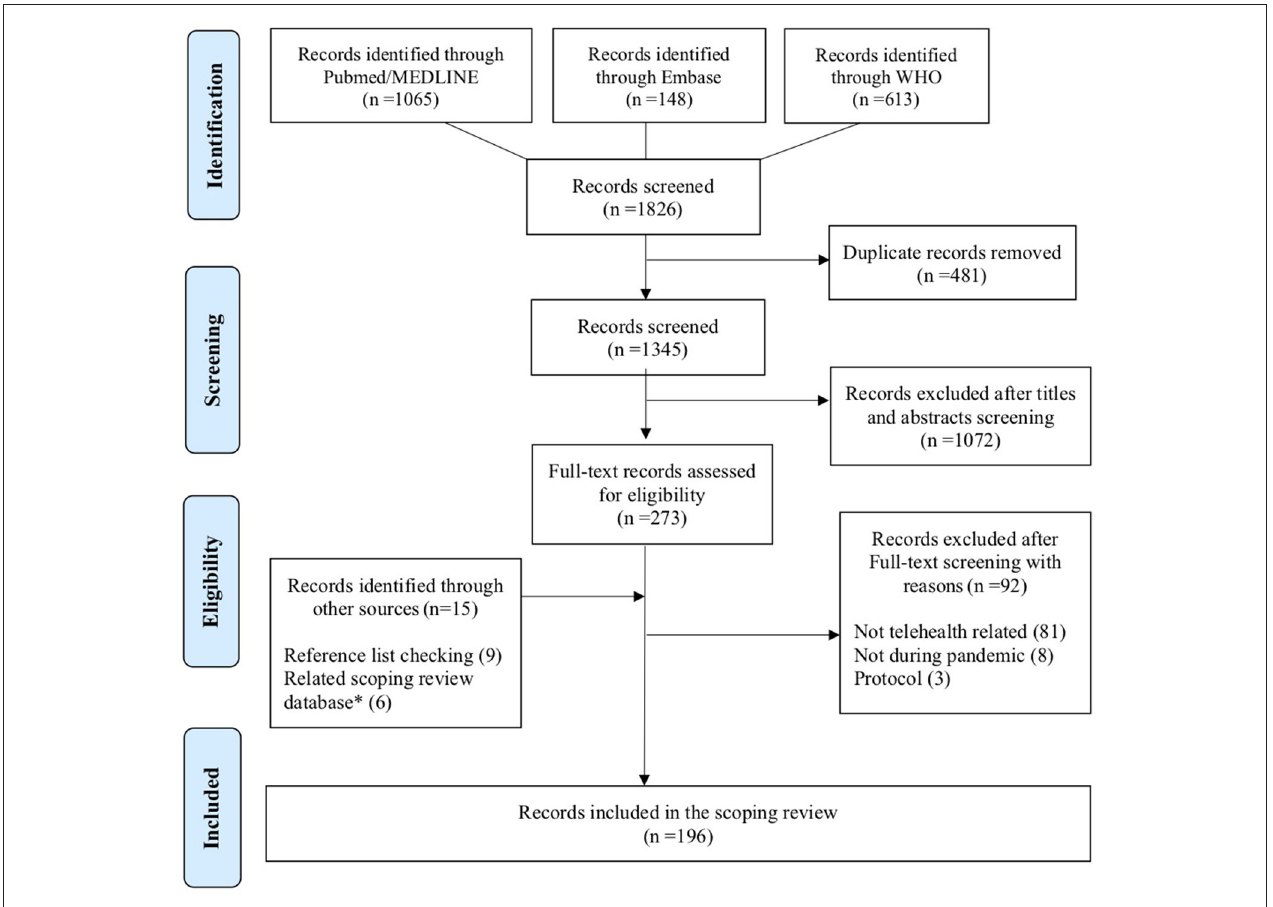
FIGURE 1 | PRISMA 2009 flowchart of the systematic review’s inclusion. *Database on telemedicine from previous scoping